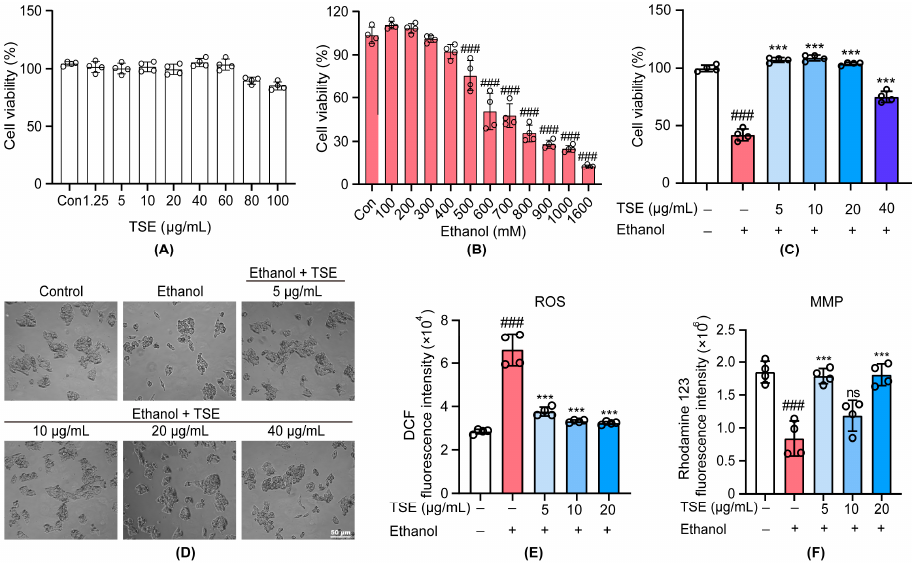
Figure 2. TSE protected HepG2 cells against ethanol-induced damage. ( A ) MTT assay of HepG2 cell viability following treatment with TSE for 24 h, n = 4 biologically independent experiments. ( B ) MTT assay of HepG2 cell viability following treatment with ethanol for 24 h, n = 4 biologically independent experiments. ( C ) MTT assay of HepG2 cell viability following pretreatment with or without TSE for 24 h before cotreatment with or without ethanol (700 mM) for 3 h, n = 4 biologically independent experiments. ( D ) Morphology of cells under microscope (magnification ×200). ( E ) Flow cytometric analysis of intracellular ROS levels detected by DCFH-DA probe, n = 4 biologically independent experiments. ( F ) Flow cytometric analysis of mitochondrial membrane potential by rhodamine 123 staining, n = 4 biologically independent experiments. Data represent the mean ± standard deviation and significant differences were analyzed by one-way ANOVA. ### p < 0.001 vs. control group; *** p < 0.001 vs. ethanol group. ns, not significant vs. ethanol